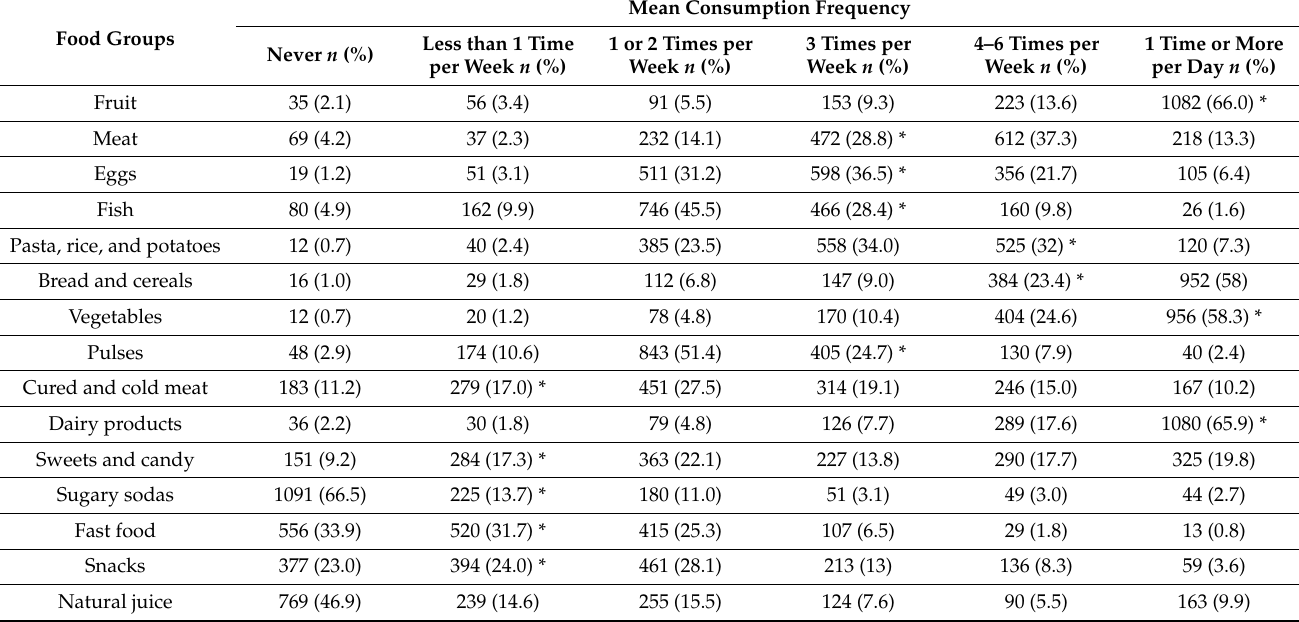
Table 2. Food consumption frequency during the period of confinement imposed during the COVID-19 pandemic and the percentage suitabilities with respect to the consumption recommended by the Spanish Society of Community Nutrition (SENC).